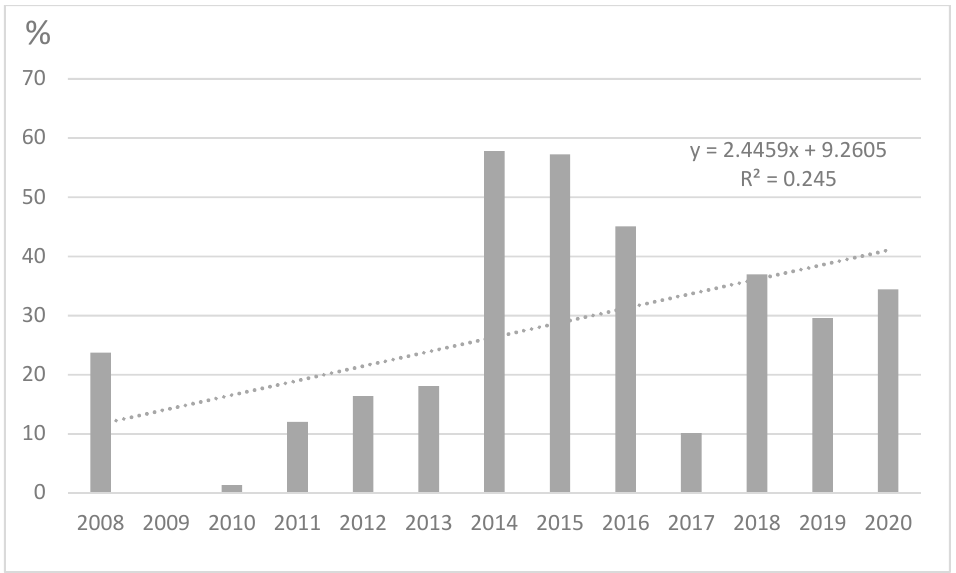
Figure 11. The percentage of the number of days with droughts (below SNQ) and floods (above SWQ).